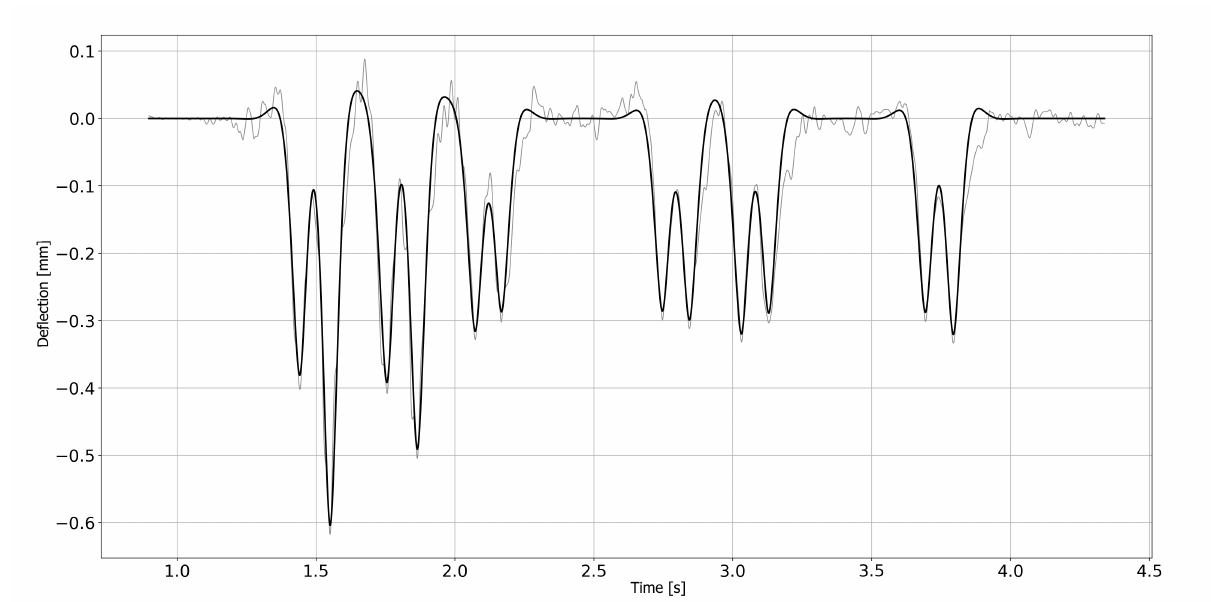
Figure 5. Analytical model comparison with measured data